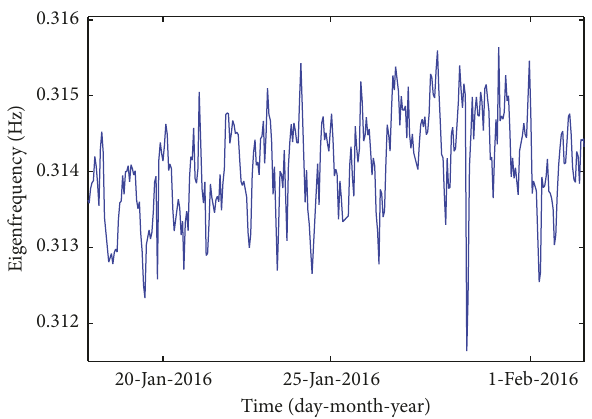
Figure 13: Trend of the first eigenfrequency where the daily changes are evident.